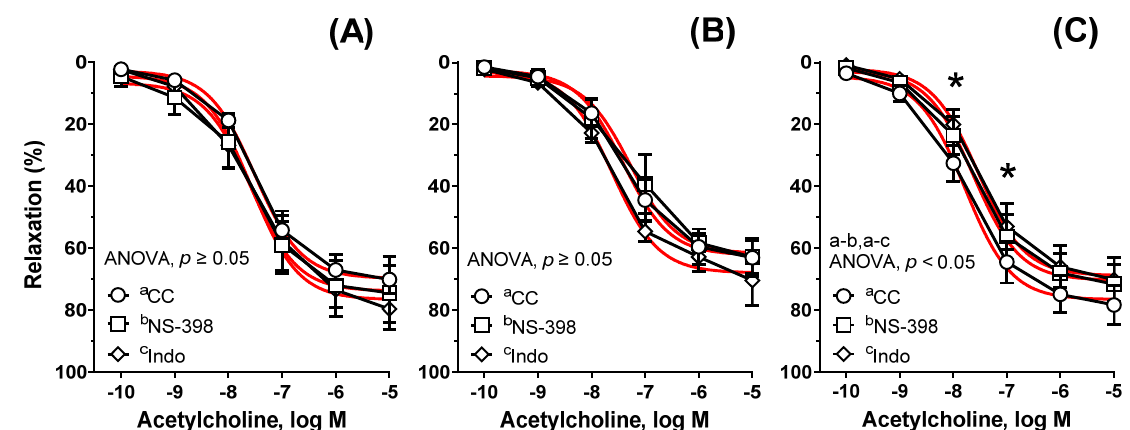
Figure 5. The influence of NS-398 and indomethacin (Indo) on the relaxant response to acetylcholine. Aortic rings from rats supplemented with Cu 6.5 ( A ), NP 3.25 + Cu 3.25 ( B ), and NP 6.5 ( C ) were pre-incubated with the selective cyclooxygenase-2 (COX-2) inhibitor (NS-398, 30 min, 10 µM) and the non-selective COX-1/2 inhibitor (Indo, 30 min, 10 µM). Results are means ± SEM, * p < 0.05 of n = 5 rats; ANOVA/Tukey’s. Preincubation with NS-398 and indomethacin attenuated vasodi- lation of rat thoracic aorta in the NP 6.5 group exclusively.